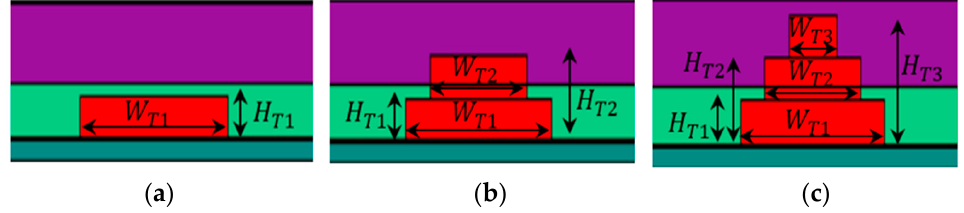
Figure 8. Illustration of the simulation setup for skin tumor evaluation in FEKO with: ( a ) W T 1 = 15 mm and H T 1 = 1.5 mm, ( b ) W T 1 = 15 mm, H T 1 = 1.5 mm, W T 2 = 10 mm, and H T 2 = 3 mm, and ( c ) W T 1 = 15 mm, H T 1 = 1.5 mm, W T 2 = 10 mm, H T 2 = 3 mm, W T 3 = 5 mm, and H T 3 = 4.5